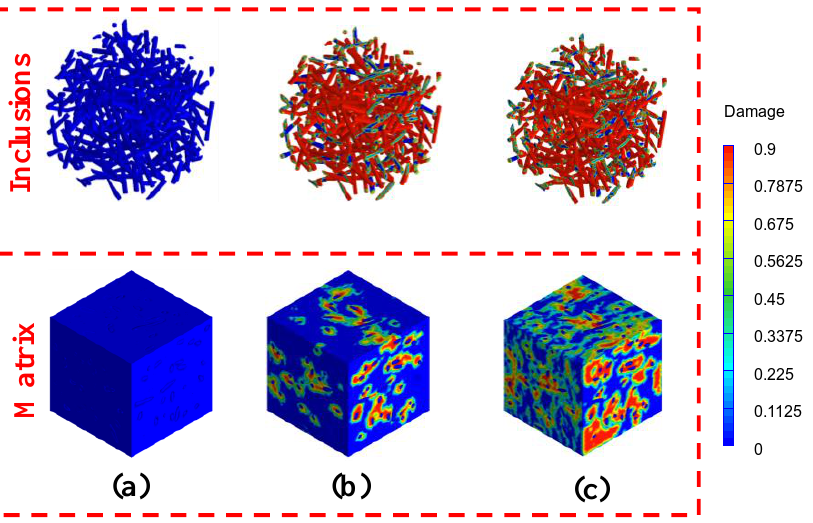
Figure 4. Damage states at 200/s rate with increasing strain for the mortar with 10% fiber content at strain states of ( a ) undeformed, ( b ) 0.0027, and ( c ) 0.0045. Table 2. Homogenized material properties for wollastonite fibers in HCP.